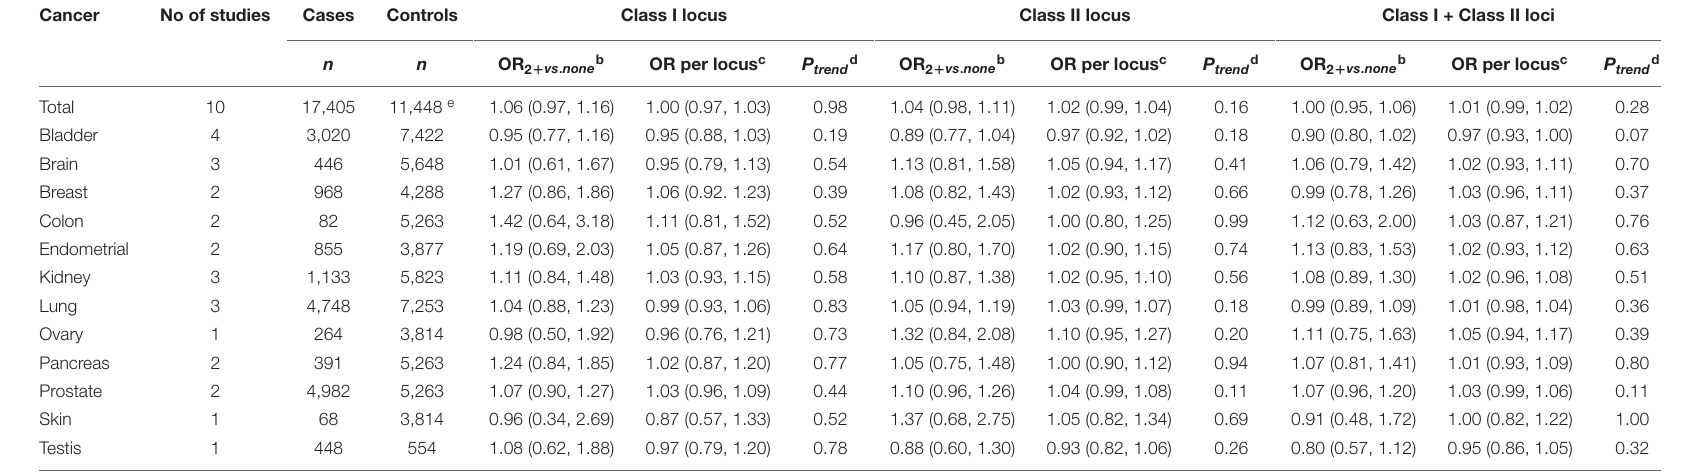
CI, confidence interval; HLA, human leukocyte antigen. a Odds ratios (ORs) were obtained from the meta-analysis summarizing estimates based on unconditional logistic regression models adjusted for sex (if possible), age, and top 10 PCs. For cancer with only one study included, ORs were obtained from unconditional logistic regression models. b ORs for homozygous for two or more loci vs. zygosity for all loci. ORs were obtained from the meta-analysis. c ORs for one increase number of homozygous loci. ORs were obtained from the meta-analysis. d Two-sided P values for trend were assessed using ordinal number of the homozygous loci with 1 degree of freedom, which were obtained from the meta-analysis if more than one study were included. e Number of unique controls included in the